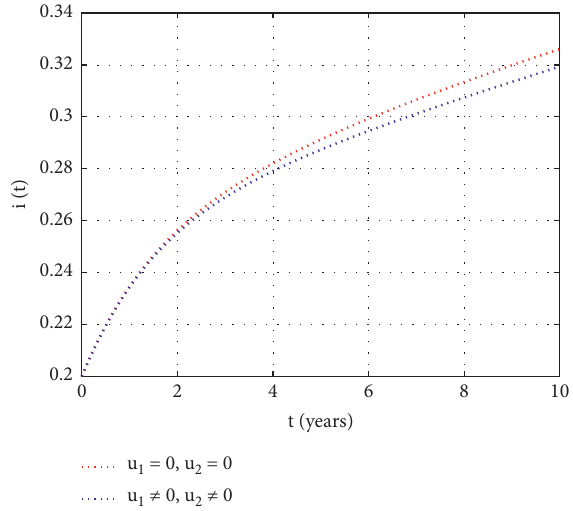
Figure 6: Simulation of HIV population size without and with